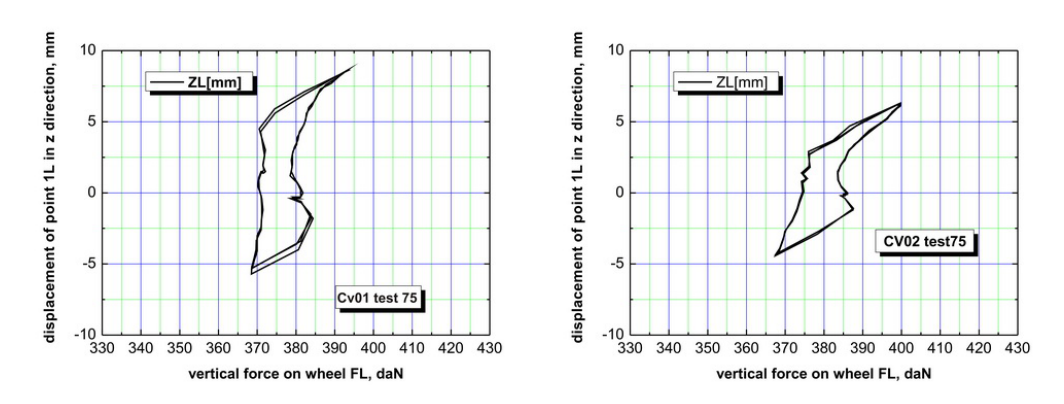
Fig. 5.4. Displacement alterations depending on vertical force during test No. 75.